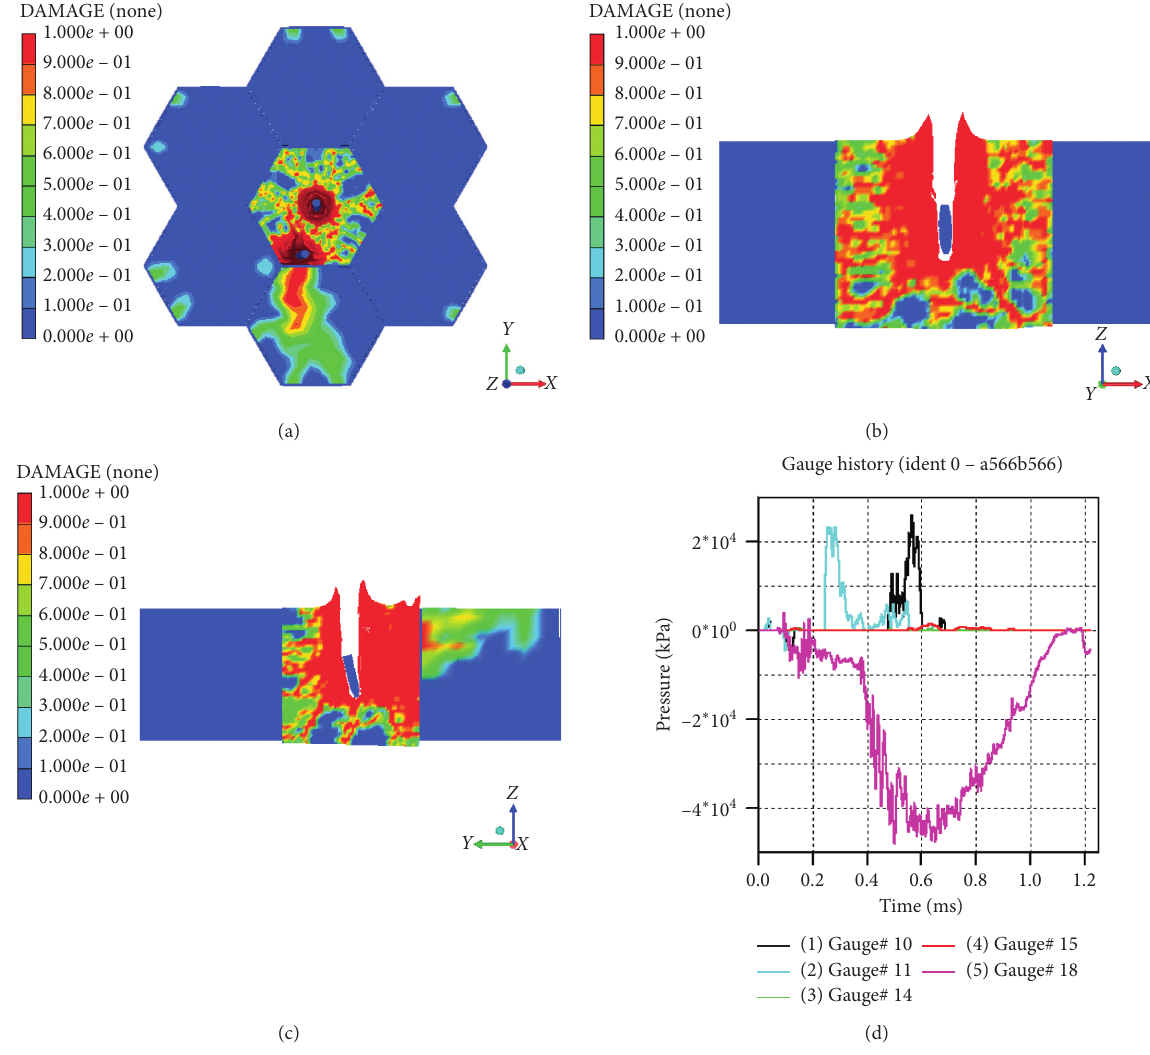
Figure 9: Target damage under configuration set 2 ( t � 1ms): (a) front view, (b) section view by XZ plane, (c) section view by YZ plane, and (d) gauge